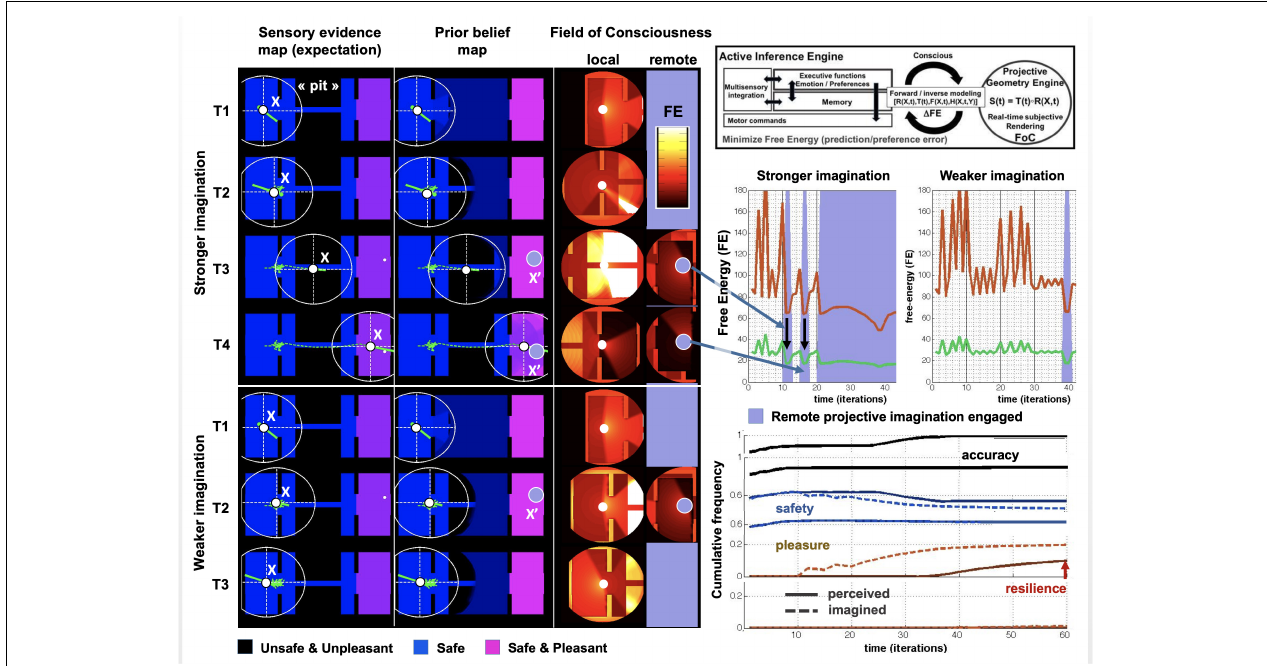
FIGURE 3 | Simplified 2D PCM-based simulation of a pit challenge. (Left Tier) Maps of a 2D world model and agent with a departure room (left: safe and anhedonic) a challenge room with a pit (center: unsafe and unpleasant), a goal room (right: safe and pleasant) (see color code). Sensory evidence maps represent factual observations, prior beliefs maps, the beliefs of the agents, and large white circles their FoC. One simulated agent is more likely to imagine remote options (stronger imagination) than the other (weaker imagination). T1 to T4 stand for time periods. Circular FoC maps show ongoing perceived (local) and transiently imagined (remote) situations; colors index Free Energy (FE, see color bar). (Right Tier , Top) General PCM architecture: a projective geometry engine is controlled by a FE-driven active inference engine. (Middle) Time courses of FE. Optimal FoC perspectives have lowest FE (green line) compared to average of other possible perspectives (red line). (Bottom) Cumulative frequencies of agents’ appraisals across time and belief accuracy. A stronger imagination leads agents to cross the pit after hesitating and reach the goal room, maximizing utility, as goal-related, optimistic projective imagination reduces overall FE near the pit. As a result, there is a gain in pleasure or resilience versus initial conditions (red arrow), and exploration with prior updating increases accuracy. A lower imagination leads agents not to explore the environment, never enjoy a better condition or greater accuracy, and to repetitively wander locally. (See Rudrauf and Debbané, 2018 for more details on this particular family of